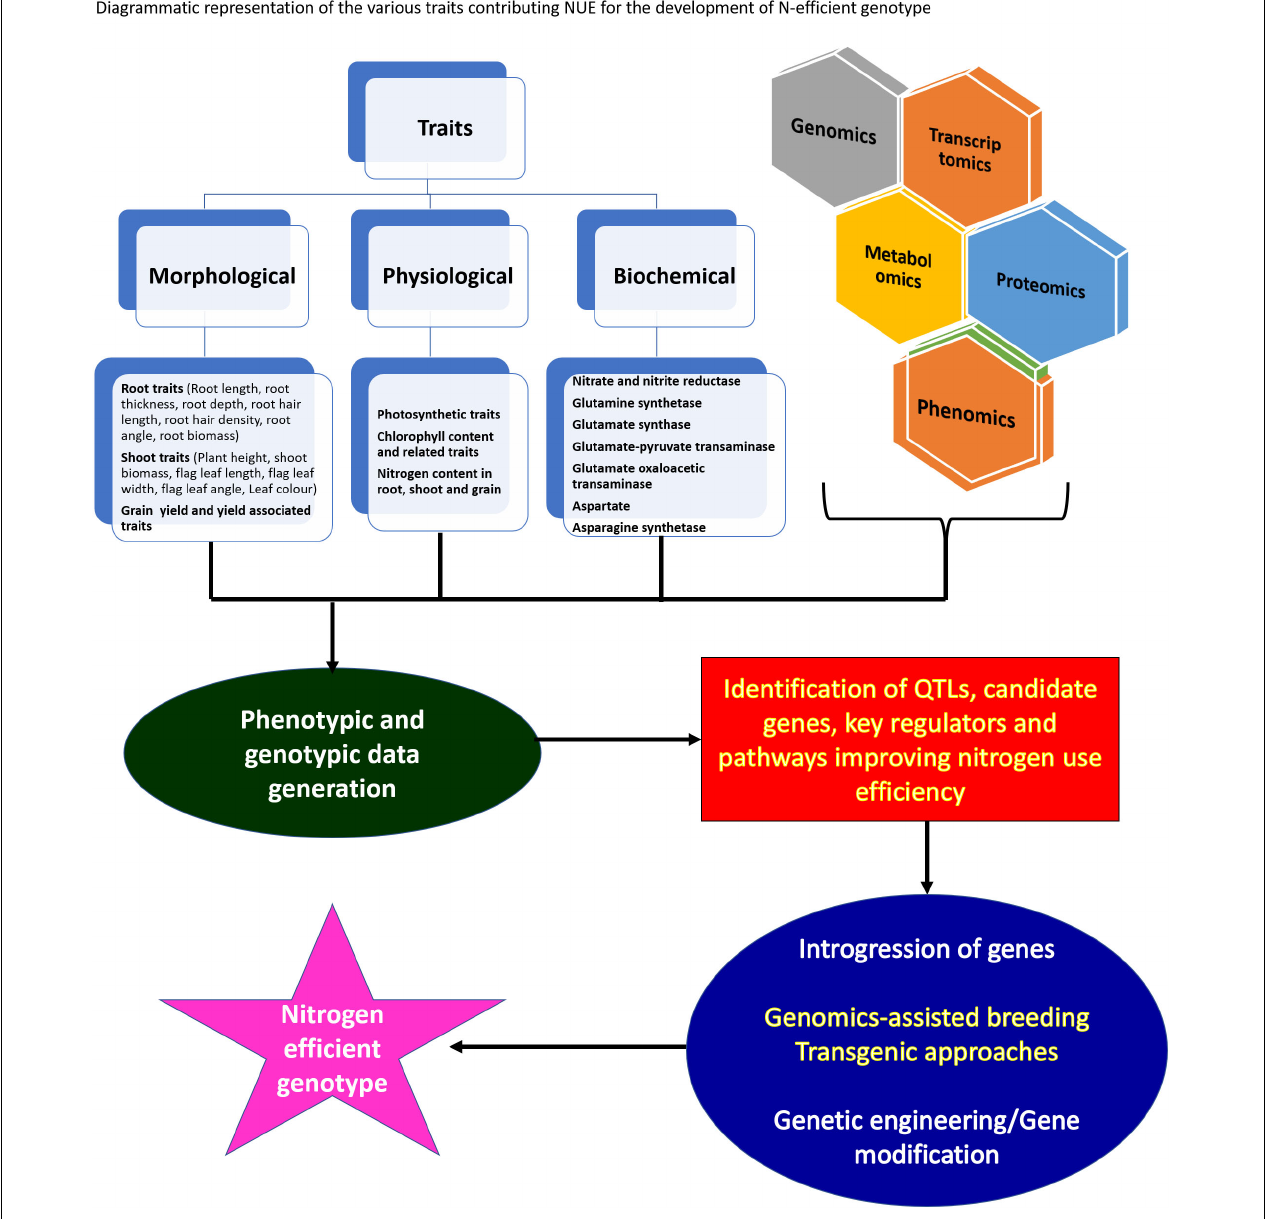
FIGURE 7 | Schematic representation of the various traits, QTL, and candidate genes contributing to the development of nutrient efficient genotypes. The pipeline for identification and deployment of traits/QTL/gene/regulatory factors associated with nitrogen use efficiency. The identified traits and donors can be used to develop suitable mapping populations to be further used in mapping of genomic regions and identification of candidate genes or key regulators associated with trait of interest using recent biotechnological approaches such as phenomics, genomics, transcriptomics, metabolomics, and proteomics. The deployment of identified QTL/gene/regulatory factors in genomics-assisted breeding programs and their functional characterization employing transgenic and genetic engineering